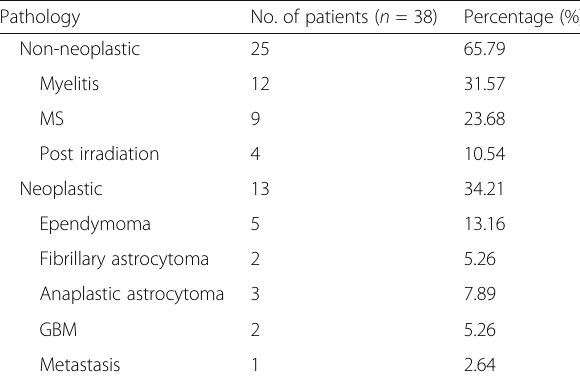
Table 1 Distribution of the studied cases according to final diagnosis and histopathology ( n = 38)